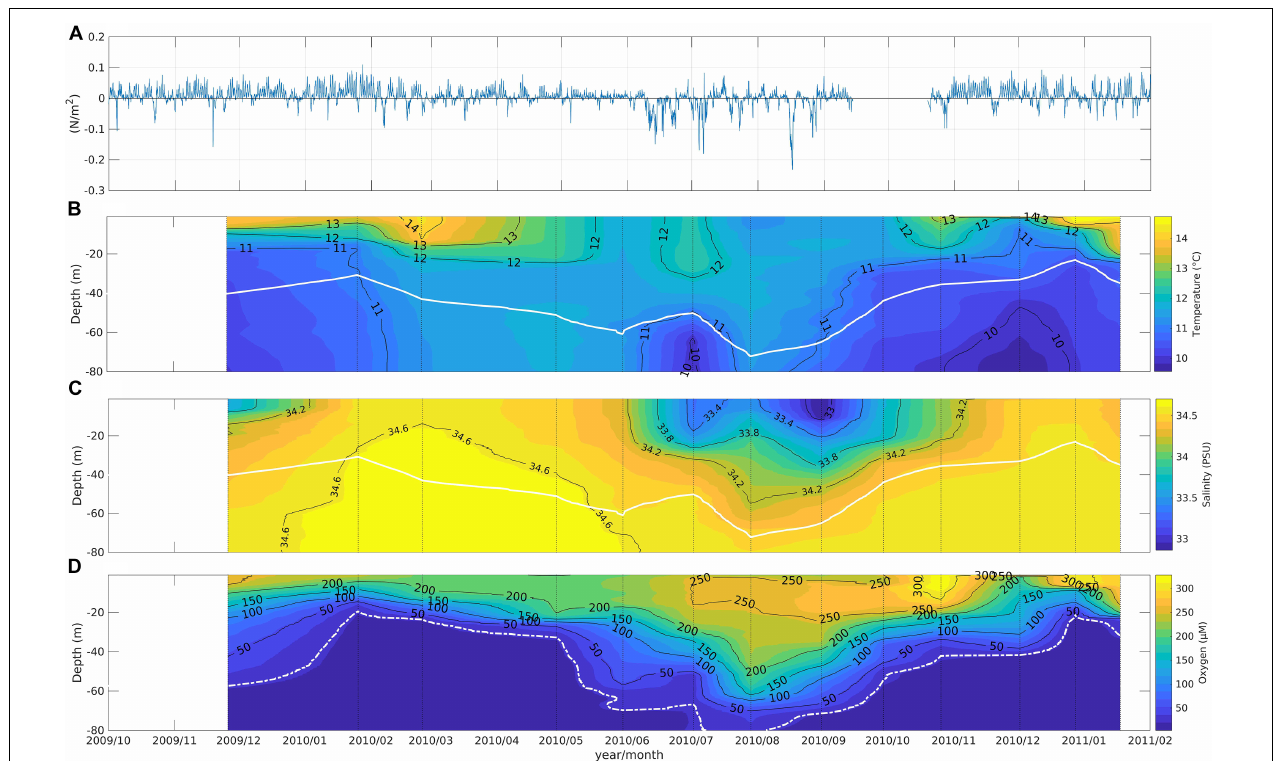
FIGURE 4 | Time series data from November 2009 through January 2011. (A) wind stress at Carriel Sur airport, Concepción (positive values represent upwelling-favorable winds); (B) temperature, (C) salinity, (D) concentration of O 2 in the water column at Station 18 off Concepción. The white lines in (B,C) represent isopycnal of 26.5 in the core of ESSW and dotted line in (D) is the isoline of 22 µ M O 2 (ca. 0.5 mL O 2 L − 1 , often considered the limit of